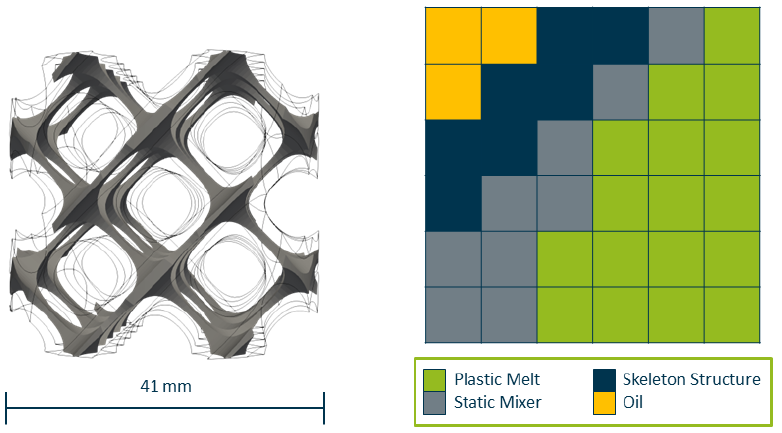
Figure 3. Immersed Boundary field with cells fixed as solid cells belonging to the static mixer or as fluid cells belonging to the oil